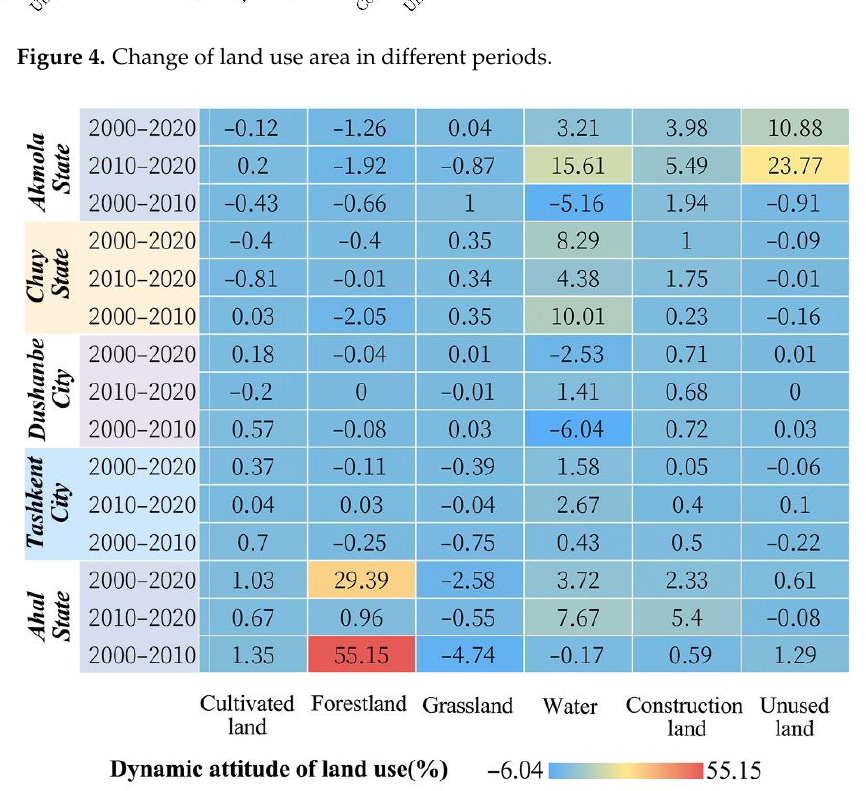
Figure 5. Dynamic degree of land use from 2000 to 2020.